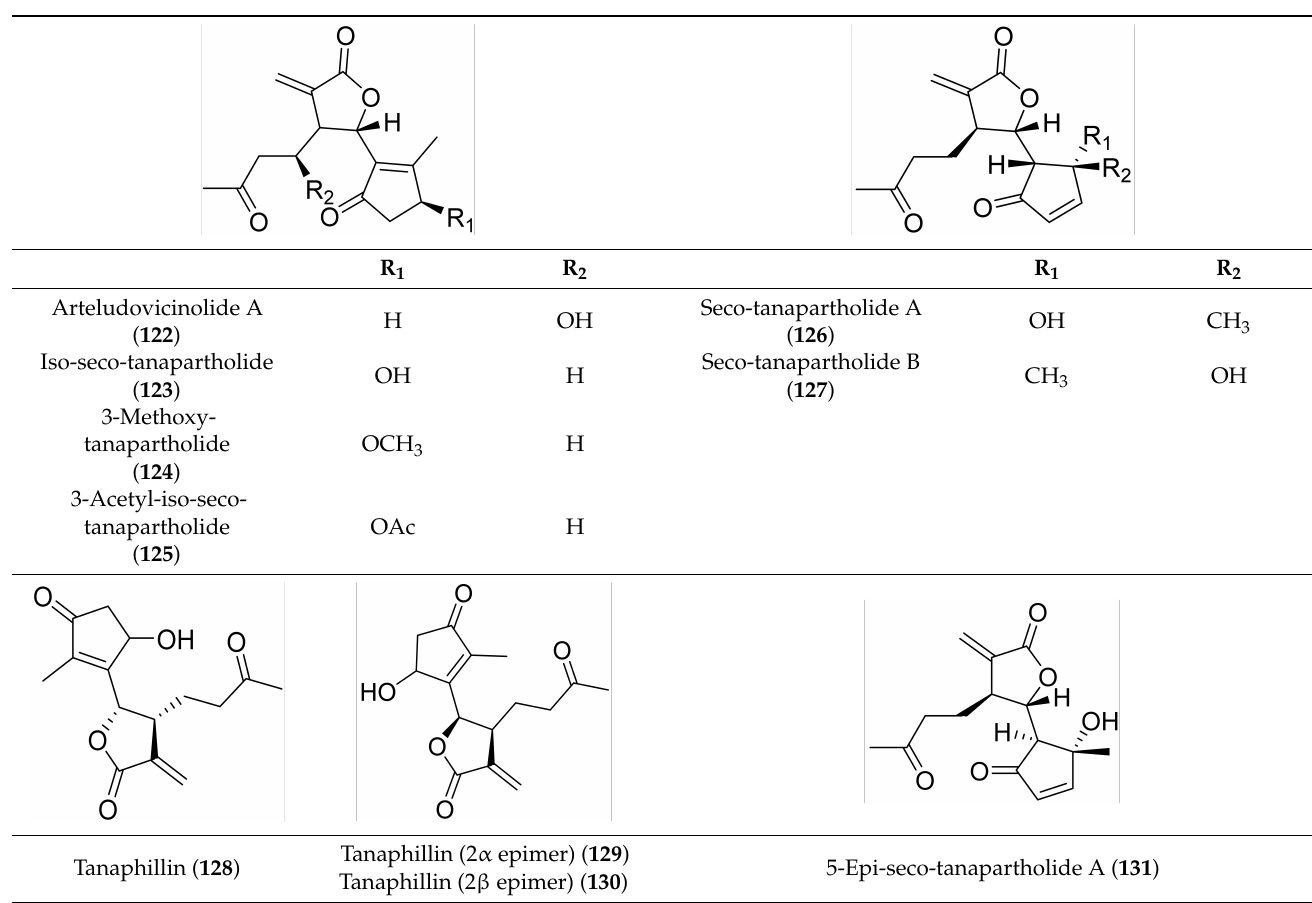
Table 11. Chemical structures of seco-guaianolides from Achillea